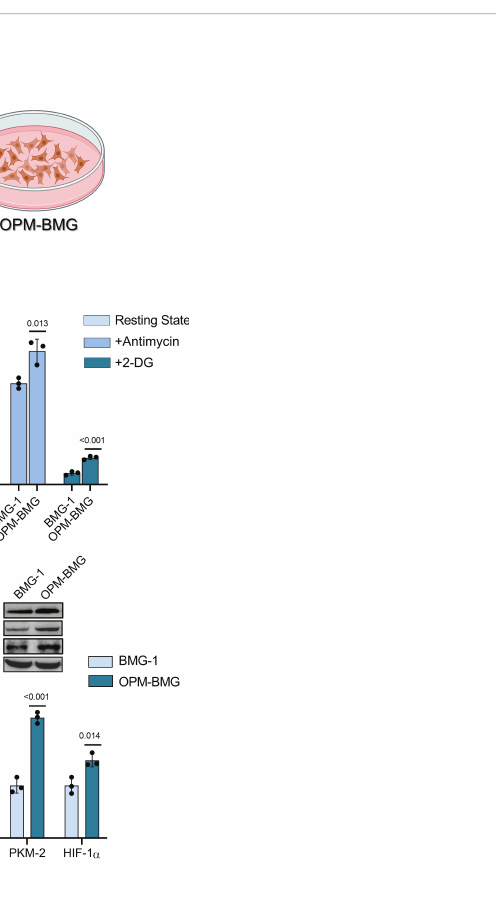
FIGURE 1 DNP-mediated OXPHOS modi fi cation showed glycolytic induction in glioma cells. (A) Graphical depiction indicating the methodology opted for establishing the OPM-BMG cell line. (B) Glucose consumption and lactate production were estimated from monolayer cells at 4-time intervals of 1 hour (h) each in BMG-1 and OPM-BMG cells (n=3). Data are presented as an average value per hour. (C) ECAR was measured as the value of pH Xtra fl uorescence lifetime signal ( m s/min./ m g protein) with or without Antimycin (5 m M) in the indicated cell lines (n=3). (D) Information derived from graph C and the overall change in acidi fi cation rate of OPM-BMG cells are presented as % relative change with respect to BMG-1. (E) Western blot of indicated glycolytic proteins presented with relative quanti fi cation among the mentioned cell lines. All data are presented as the mean ± SD; an unpaired two-tailed Student ’ s t-test was performed to calculate the statistical signi fi cance, and P -values (BMG-1 versus OPM-BMG cells) are mentioned in the